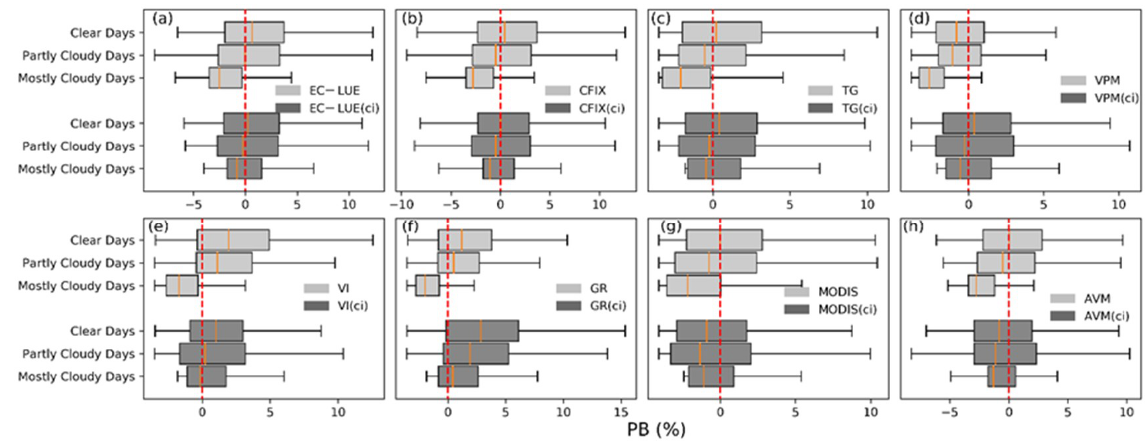
Figure A3. The deviation of the models under different cloud cover conditions. The light-colored part boxplots are the deviation statistics percentage bias (PB, %) of the existing models’ GPP predictions compared with the EC − tower GPP for each site under different cloud cover conditions. The dark part (ci) is the change after multiplying the result of each model by the cloud cover factor (F_CI), according to Equation (3). adding the cloud cover index (CI). The red dotted line denotes the line where PB = is equal to 0, i.e., unbiased, and colored vertical line in boxplots are the means. Where ( a ) is EC-LUE (eddy covariance-light use efficiency model), ( b ) is CFIX (carbon fixation model), ( c ) is TG (temperature-greenness model), ( d ) is VPM (vegetation photosynthesis model), ( e ) is VI (vegetation-indices model), ( f ) is GR (green-ness-radiation model), ( g ) is MODIS (moderate resolution imaging spectroradiometer model), and ( h ) is AVM (alpine vegetation model).